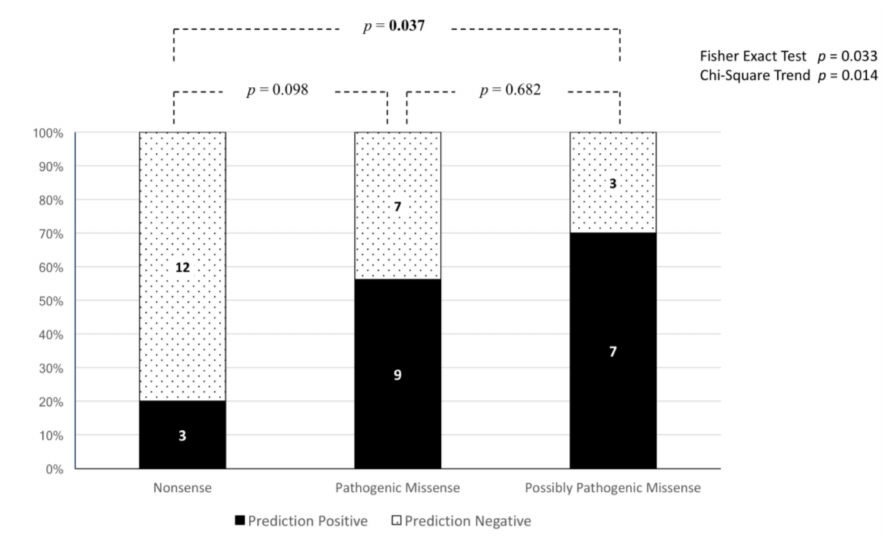
Figure 4. Ratio of HGMD nonsense, pathogenic missense and possibly pathogenic missense variants ≤ 3 nucleotides from splicing sites predicted to either impact splicing (prediction positive) or have a neutral effect on splicing (prediction negative). In the bars are the absolute numbers for each group. Over the bars, p -values for pairwise comparisons, obtained according to Tukey’s method, are represented. In the top-right corner, the global p -values for the Fisher’s exact test and for the Chi-Square trend test are presented to compare greater proportions (i.e., more than two).